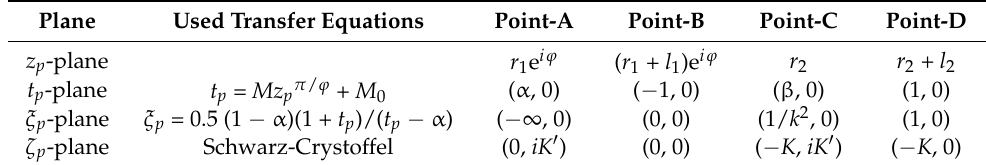
Table 2. The successive coordinate transformations of the inclined plate. Plane Used Transfer Equations Point-A